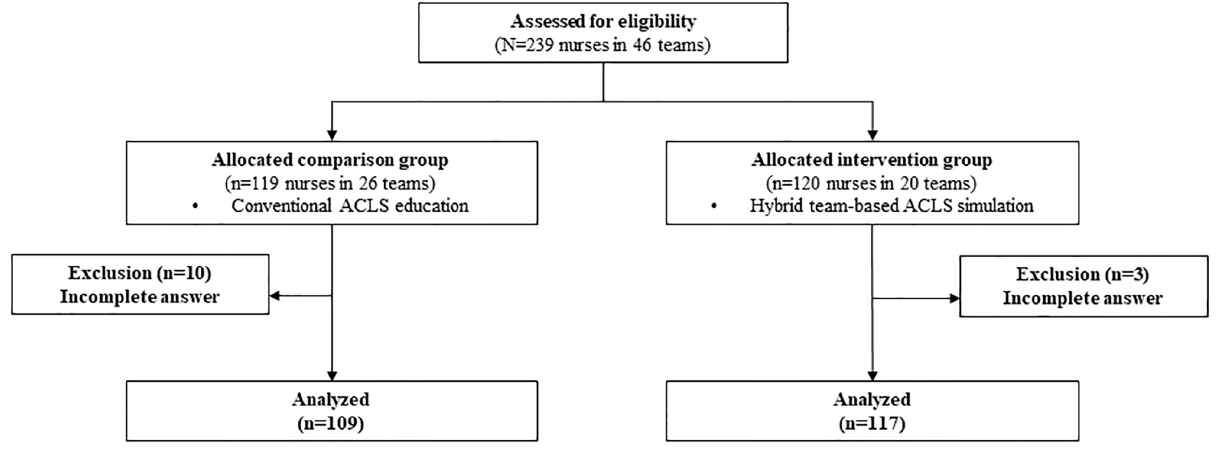
Fig 3. Participant flow